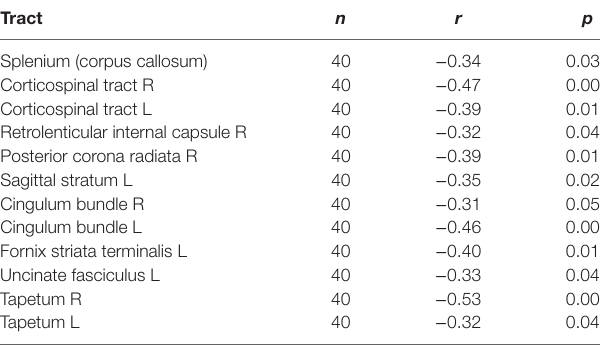
TaBle 5 | White matter integrity and total blast exposure. Tract